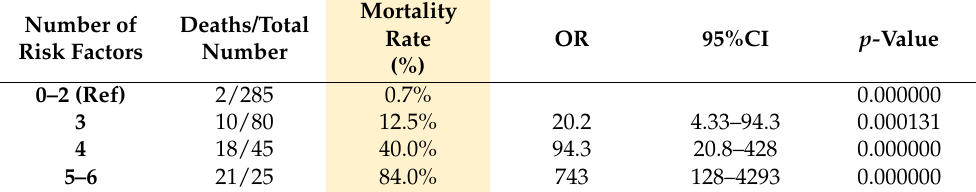
Table 3. Stratification of postoperative mortality—mortality rates according of risk factor